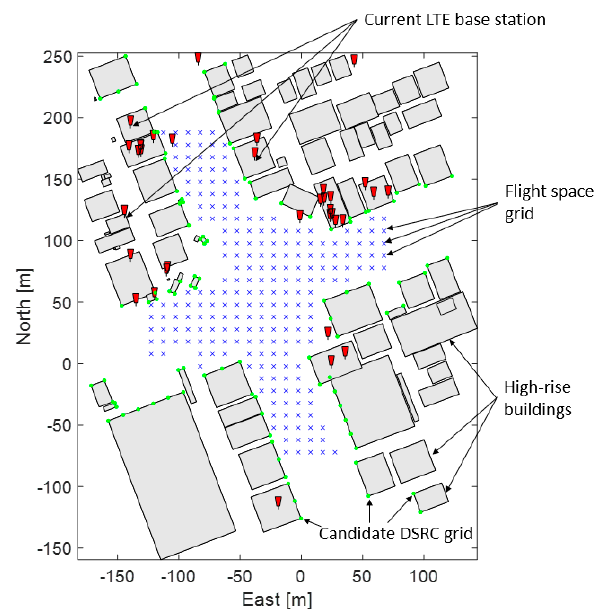
Figure 3. Current LTE base stations, candidate dedicated short range communication (DRSC) transceiver locations at the buildings along the main street, and flight space grids on a 2D plane in Gangnam, Seoul, South Korea.